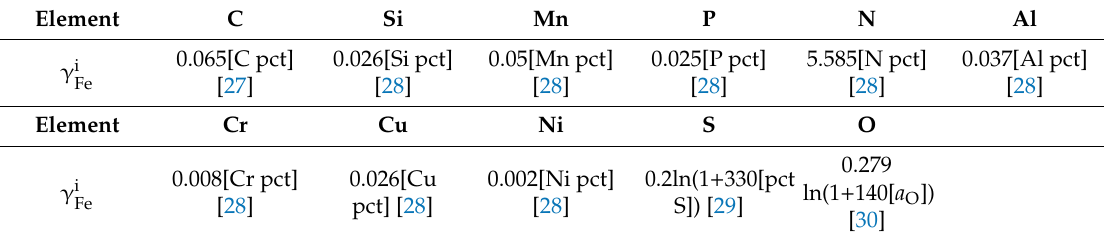
Table 3. E ff ect of steel composition on surface energy of liquid steel (J / m 2 ).